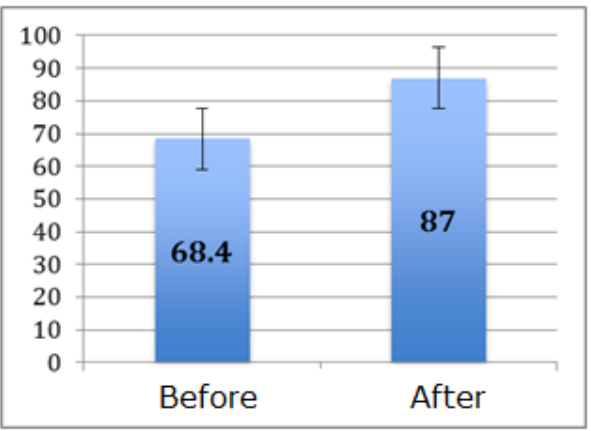
Figure 13. Participants’ agreements for using an automated vehicle “before” versus “after” the users experience of HCAI-based automation.